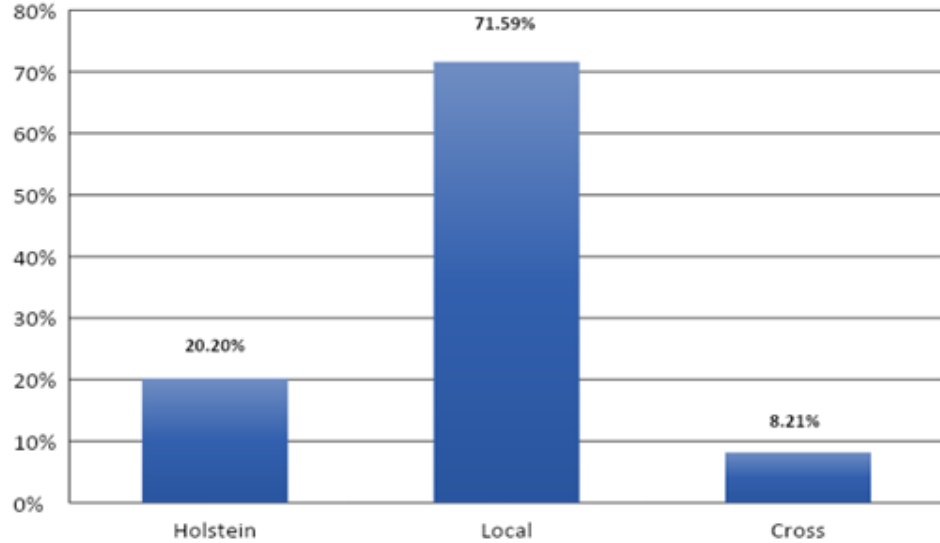
Figure 11. Distribution of lesions by age group.